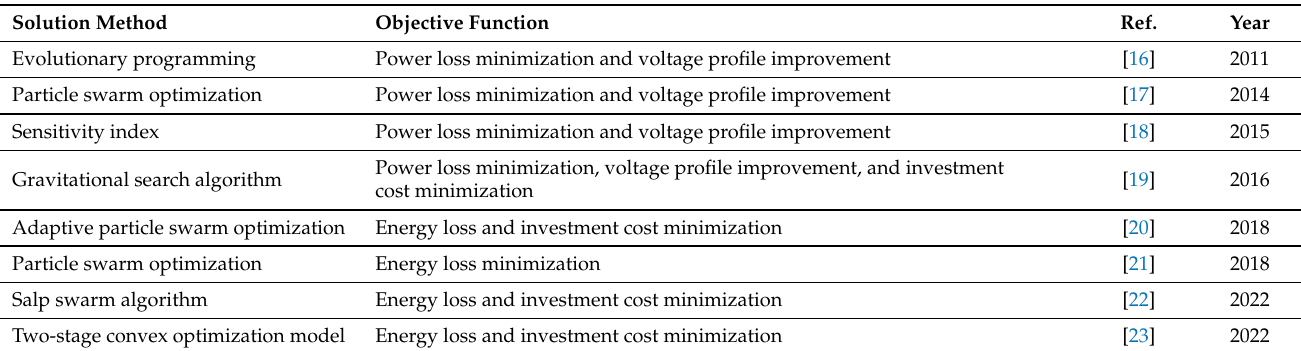
Table 1 summarizes the different algorithms used in the literature to solve the problem concerning the placement and sizing of D-STATCOMs in distribution networks. Table 1. Main literature reports regarding the optimal placement and sizing of D-STATCOMs in distribution